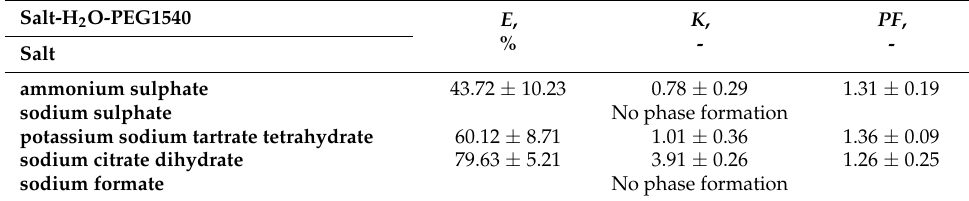
Table 2. The influence of ATPS system composition on xylanase